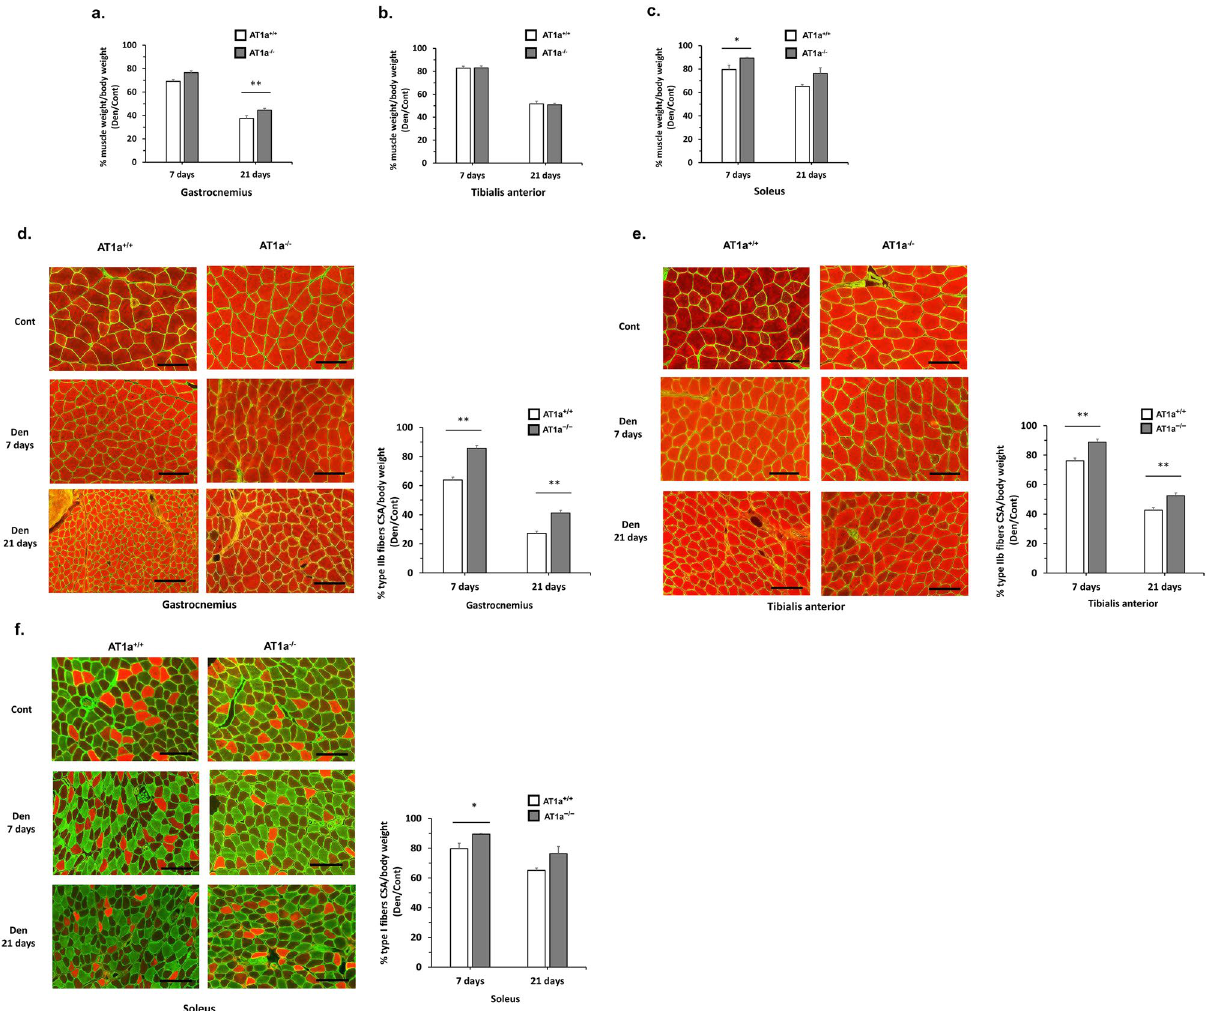
Figure 1. AT1a receptor loss alleviated denervation-induced muscle atrophy. ( a – c ) Change in skeletal muscle weight per body weight in denervated gastrocnemius ( a ), tibial anterior ( b ), soleus ( c ) muscles at 7 and 21 days postdenervation. The graphs show the fold decrease in each muscle weight normalized to body weight in denervated muscle (Den group) compared to sham-operated group as control (Cont group). ( d–f ) Immunohistochemistry analysis of muscle fibers. Triple staining with type IIb muscle fibers stained red, type I muscle fibers stained green, and laminin stained green. Cross-section of muscle fibers in gastrocnemius ( d ), tibial anterior ( e ), and soleus ( f ). Scale bar: 100 μm. The graphs show the fold decrease in each cross- sectional area normalized to body weight in denervated muscle (Den group) compared to sham-operated group as control (Cont group). AT1a +/+ -Cont group, n = 6; AT1a +/+ -Den group at 7 days postdenervation, n = 7; AT1a +/+ -Den group at 21 days postdenervation, n = 7; AT1a −/− -Cont group, n = 5; AT1a −/− -Den group at 7 days postdenervation, n = 6; AT1a −/− -Den group at 21 days postdenervation, n = 6. Values are means ± SE. *P < 0.05, **P <